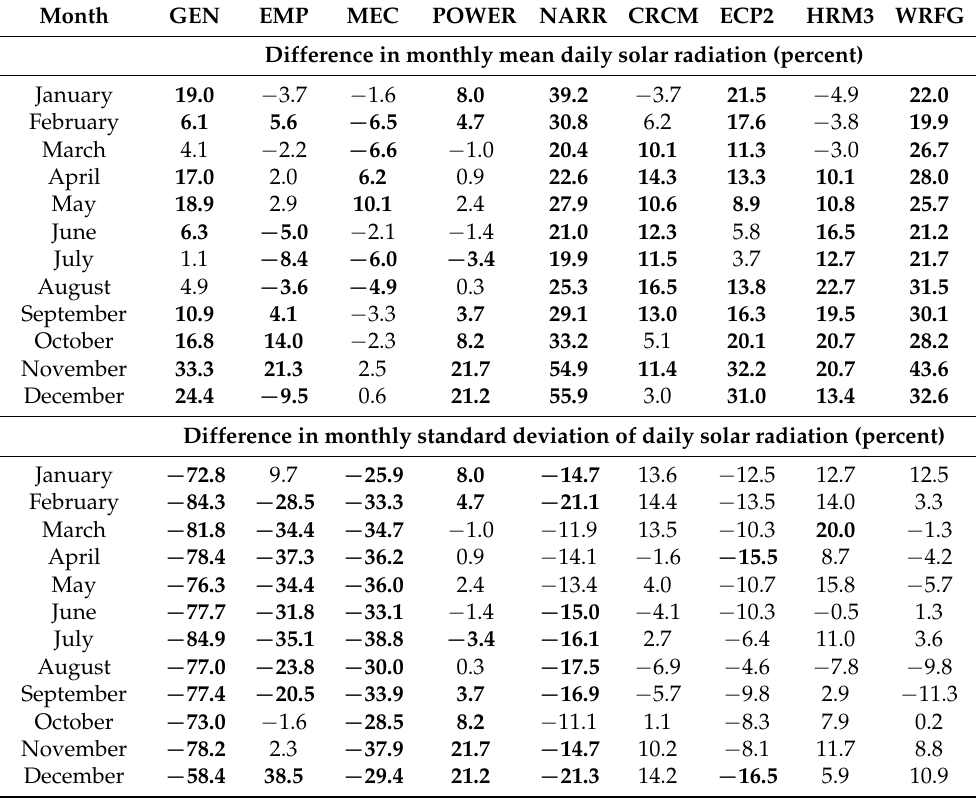
Table 2. Percent difference by month in the mean and standard deviation of daily solar radiation for the different radiation sources compared to observed radiation at Hancock, Wisconsin. Bolded values indicate significant differences at the 99 percent probability level based on a paired t -test (assuming unequal variance) for equality of means or a F-test for equality of